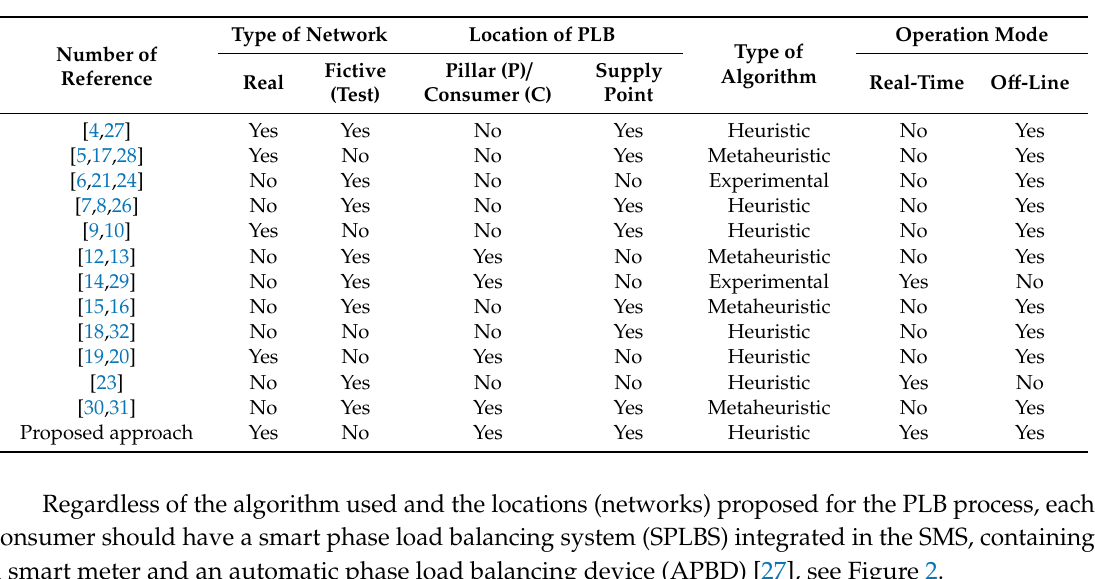
Table 1. A comparative state-of-the-art between proposed method and the literature.